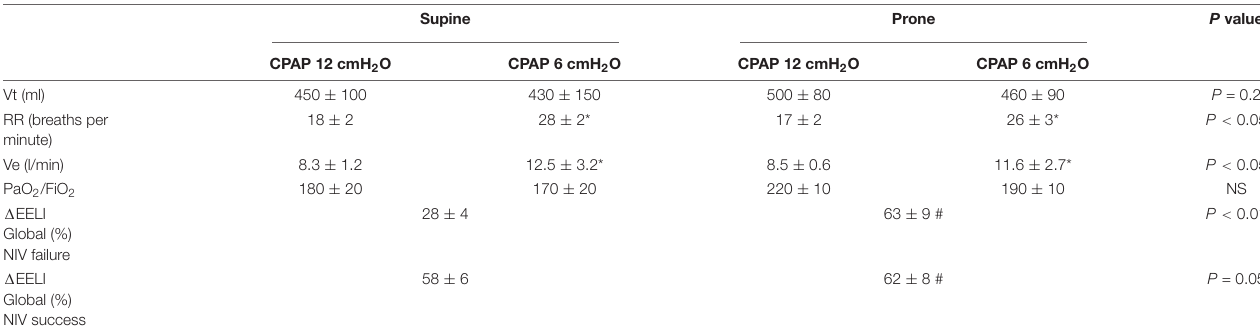
TABLE 2 | Respiratory parameters during CPAP trials, in both